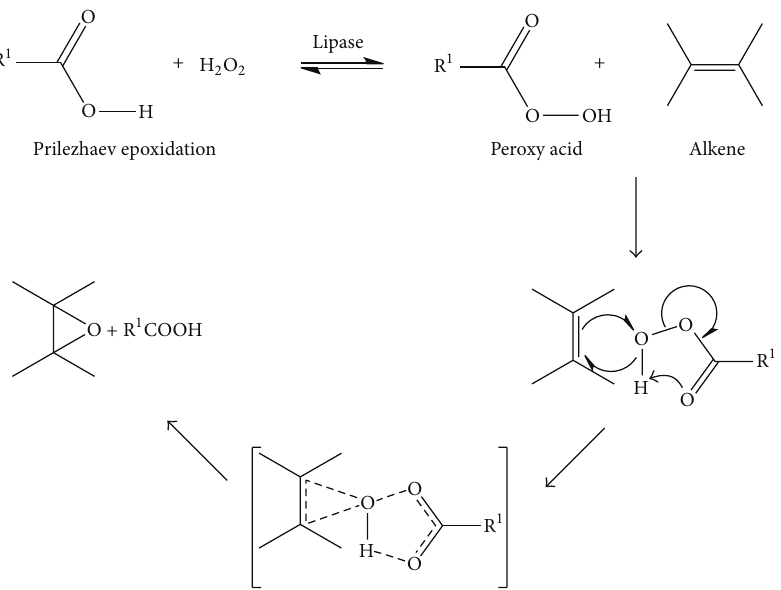
Scheme 2: Mechanism of Prilezhaev epoxidation of